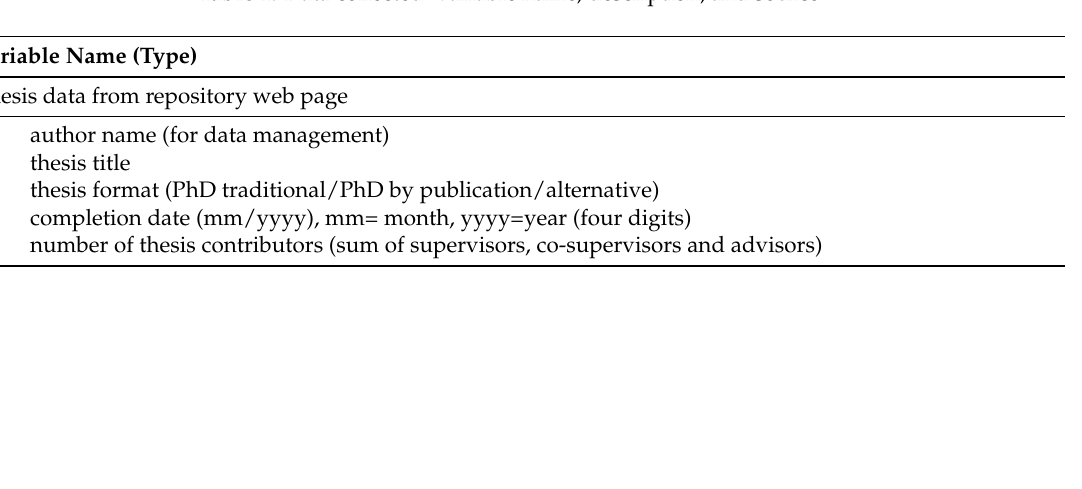
Table 1. Data collected: variable name, description, and